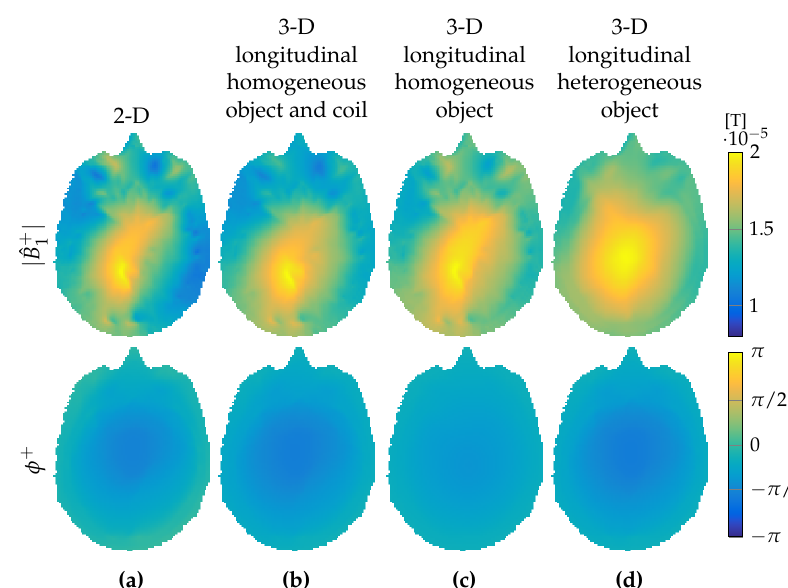
field obtained 1 1